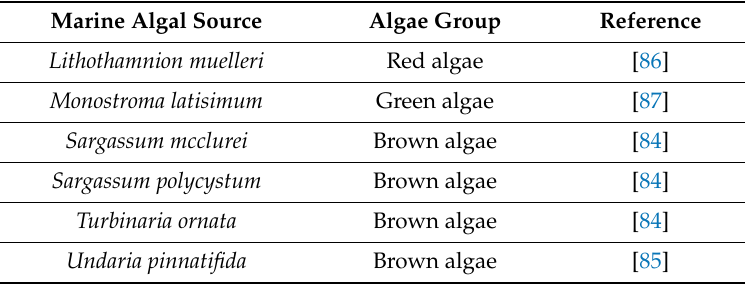
Table 7. Marine algae source with antiviral activity attributed to